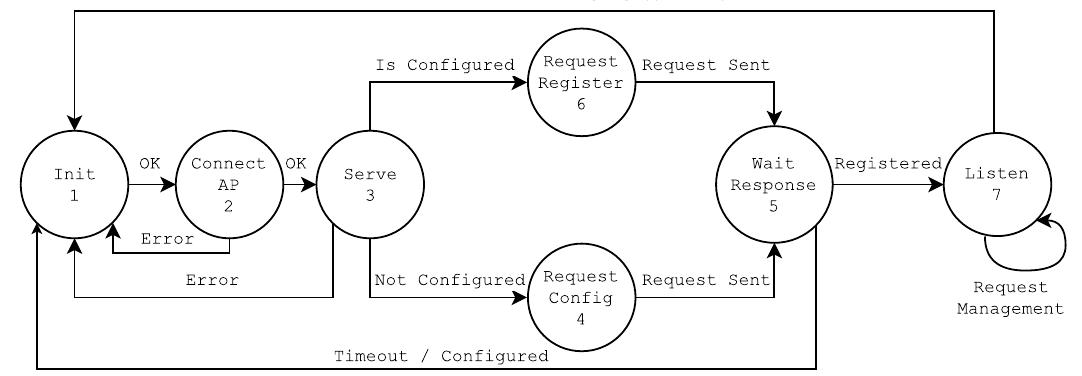
Figure 5. Finite state machine implemented by an